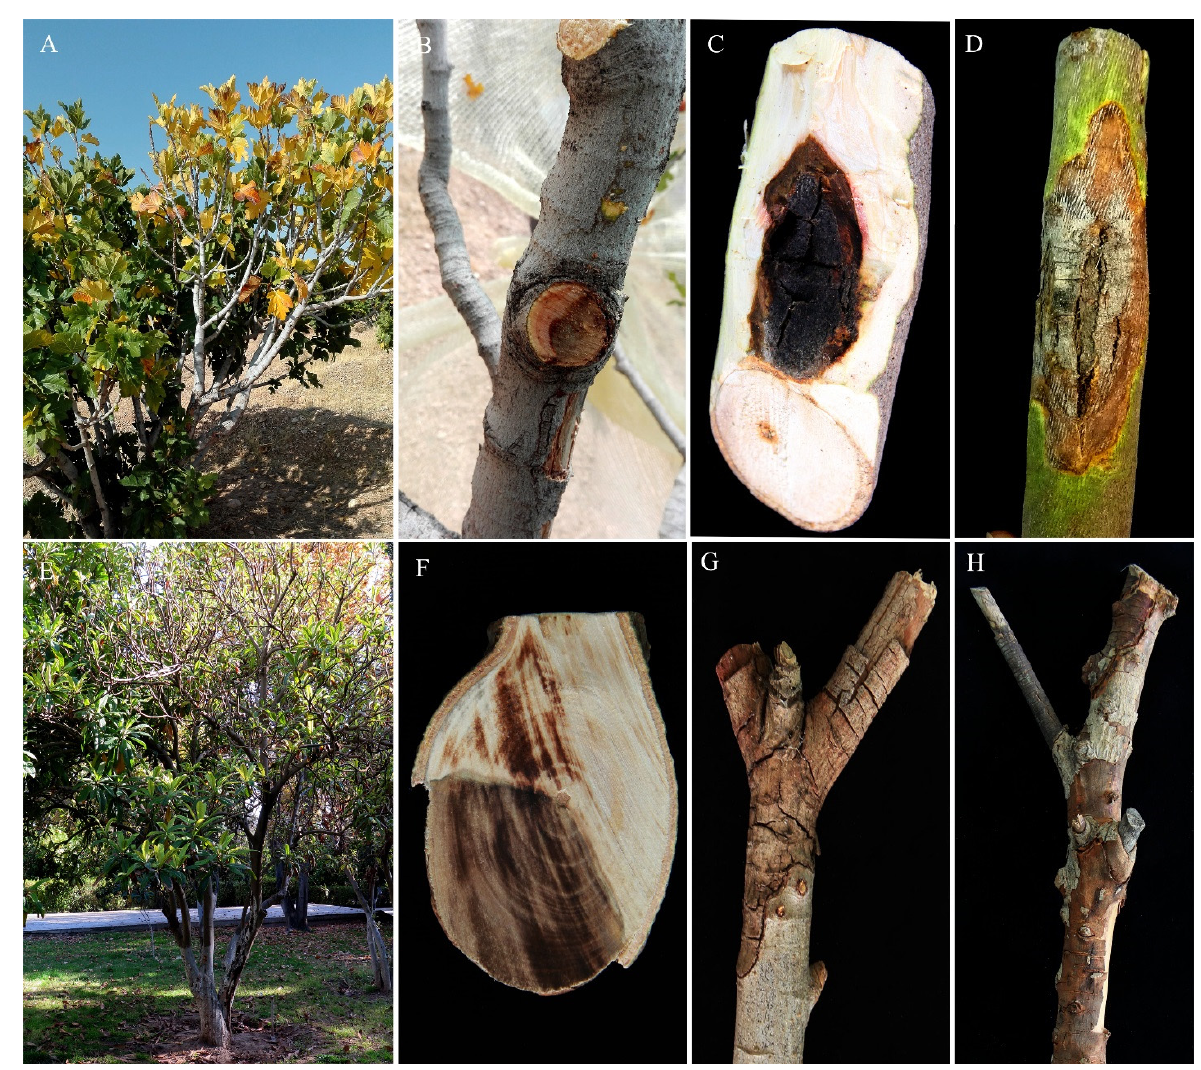
Figure 1. Cankers and twig dieback caused by Stilbocrea banihashemiana sp. nov. on main stem and branches of fig (( A , B ): cv. Sabz; ( C ): cv. Siah; ( D ): cv. Pouzdonbali) and loquat ( E – H ) trees in Fars Province, Iran. ( A , E ): External symptoms, including leaves yellowing, defoliation, and branch dieback. ( B , F ): Internal symptoms, including brown to dark brown discoloration of wood tissues appearing as wedge-shaped necrosis in cross-sections of infected stems. ( C , D ): Discolored, reddish- brown, sunken, elongated cankers with intersecting longitudinal and transverse bark crackings on the main stem and branches of infected fig trees. ( G , H ): Dieback symptoms resulting from the expansion of lesions girdling the stems of loquat trees.